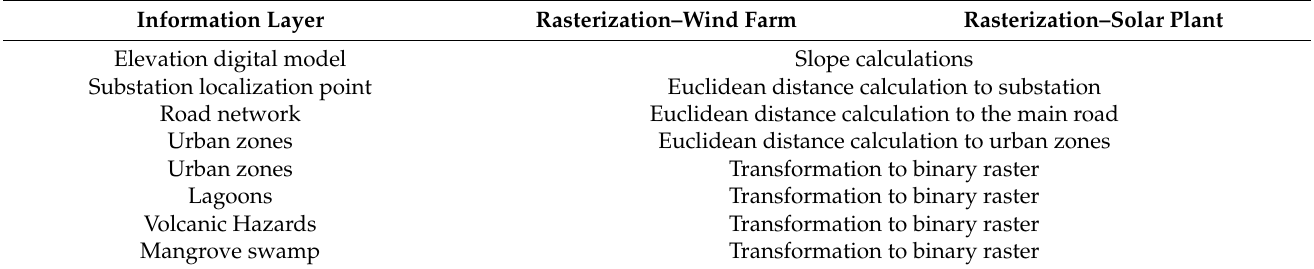
Table 3. Functions applied to re-scaled variables.